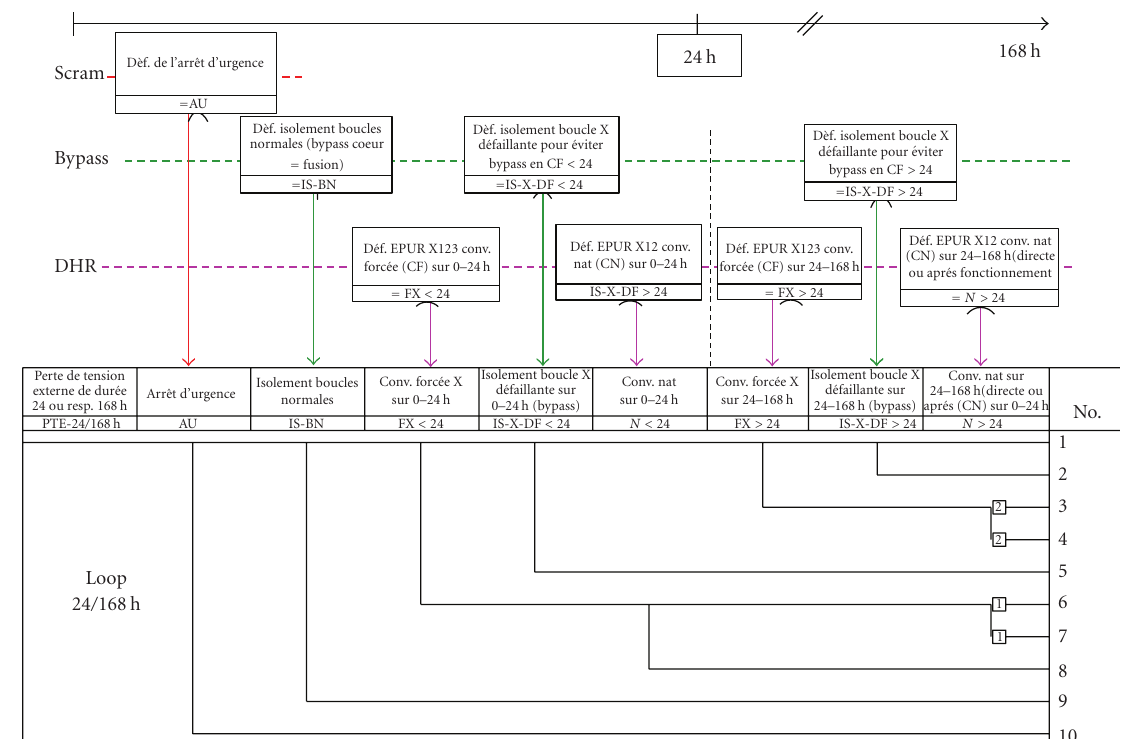
Figure 3: Event tree for LOOP IE (representative of the pressurized situation) in GFR